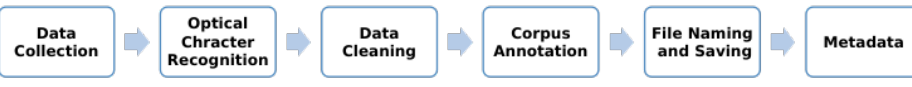
Figure 1. Methodological steps of the corpus